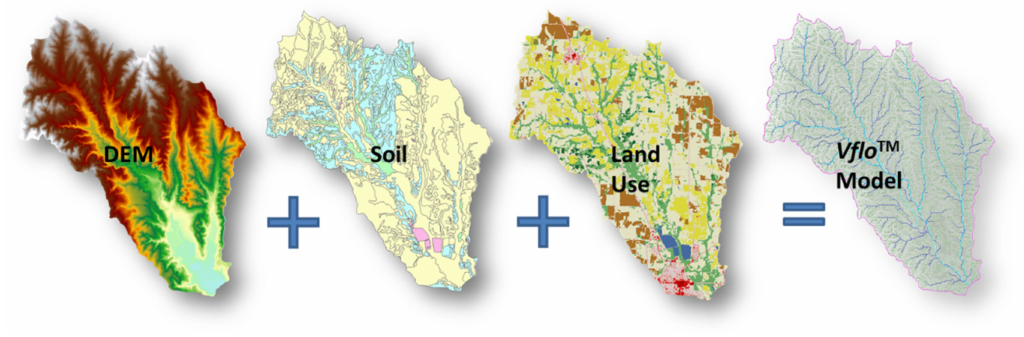
Figure 4. Cowleech Fork of the Sabine River, Texas—component data layers in Vflo TM